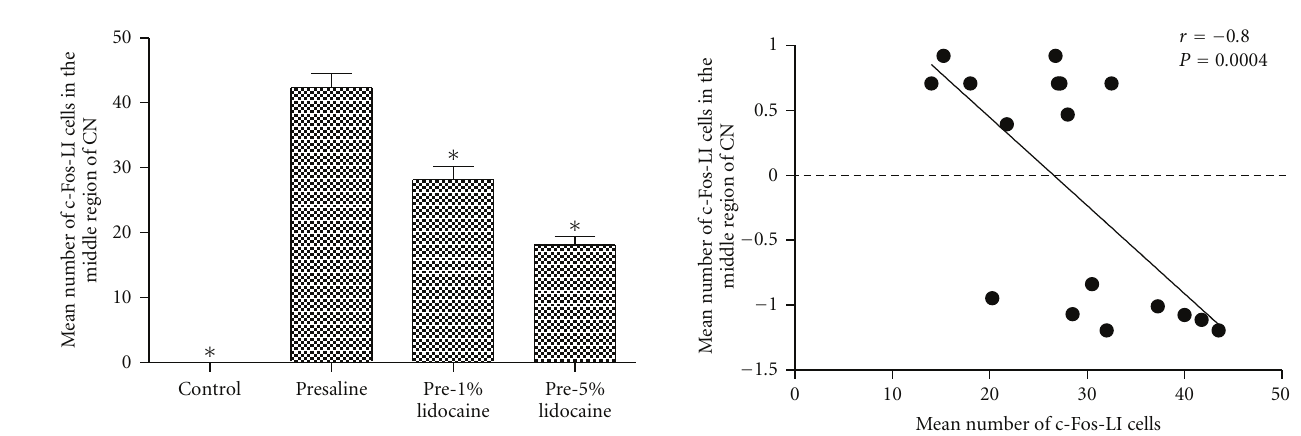
Figure 9: Linear regression of the mean number of c-Fos-LI cells and mechanical withdrawal scale (presented as log 10 -gram) four weeks after chronic constriction injury (each point represents an individual animal; r 0 . 80, P 0 . (cid:2)(cid:3) (cid:0)